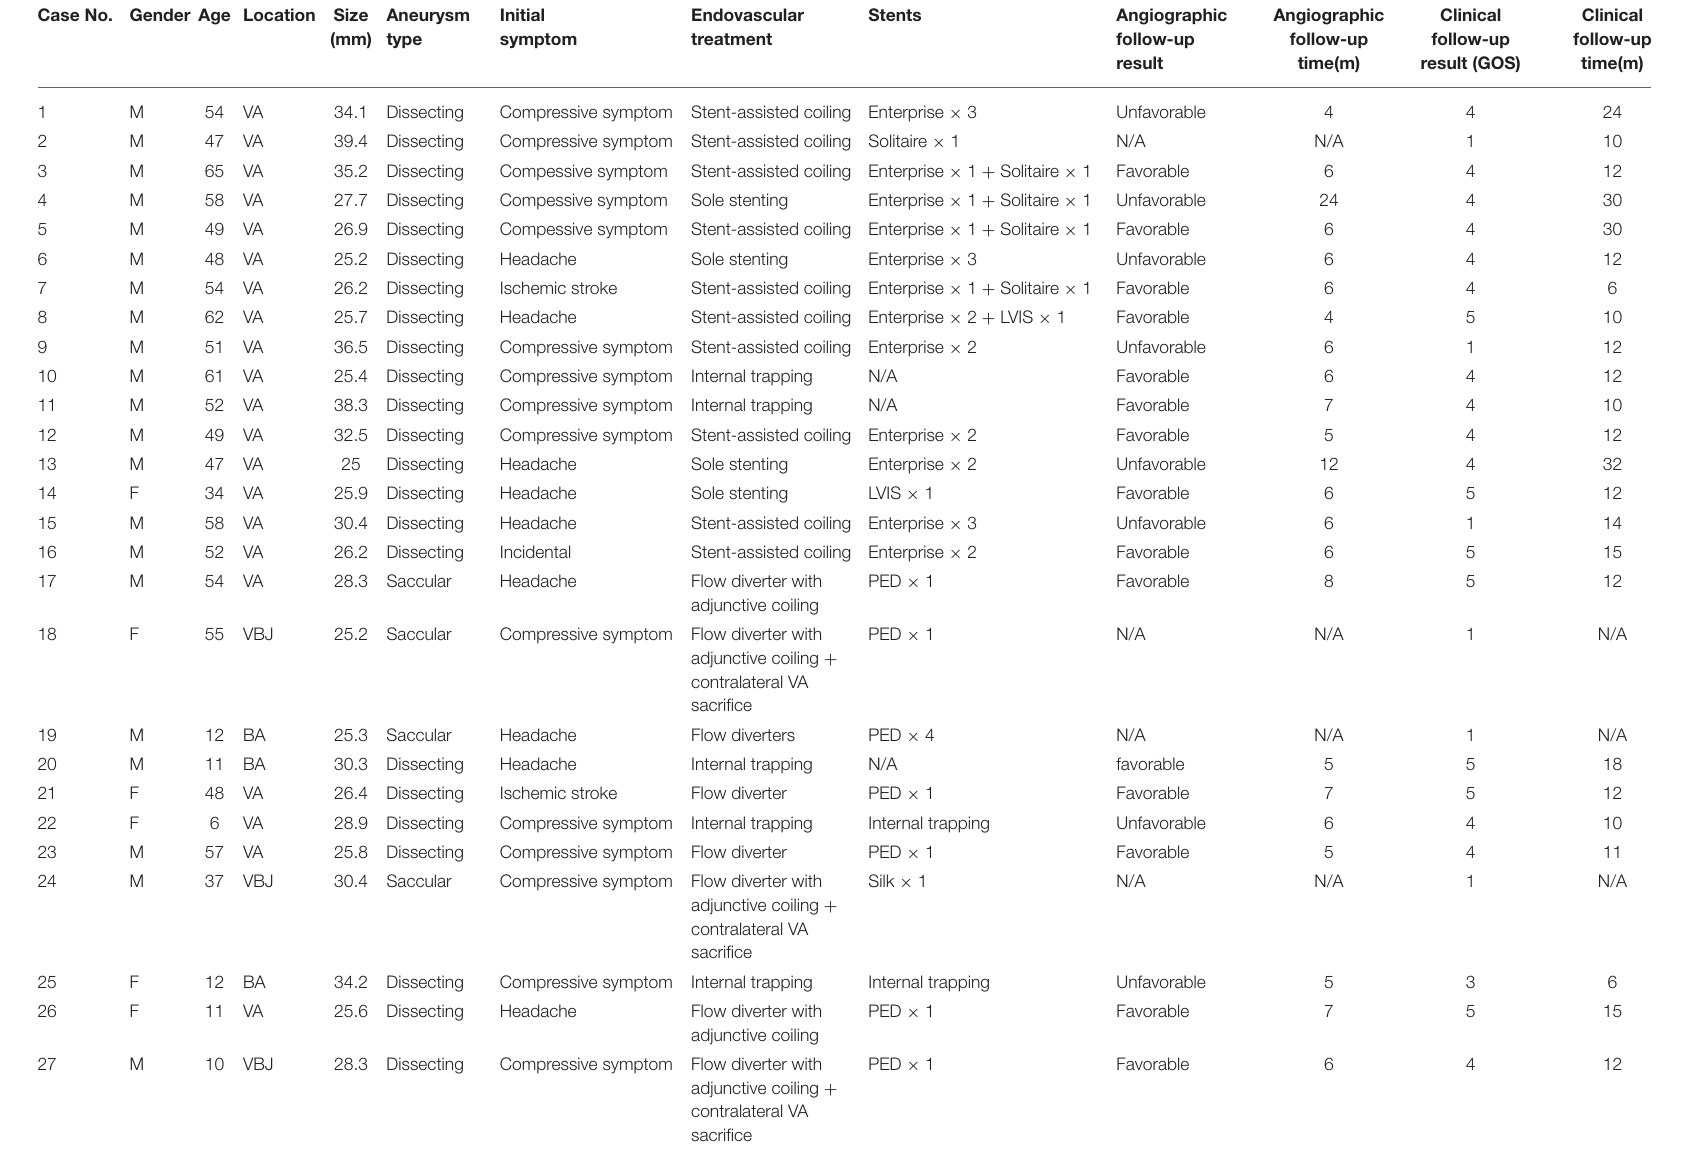
TABLE 1 | Details of 27 patients with giant vertebrobasilar aneurysms. Case No. Gender Age Location Size